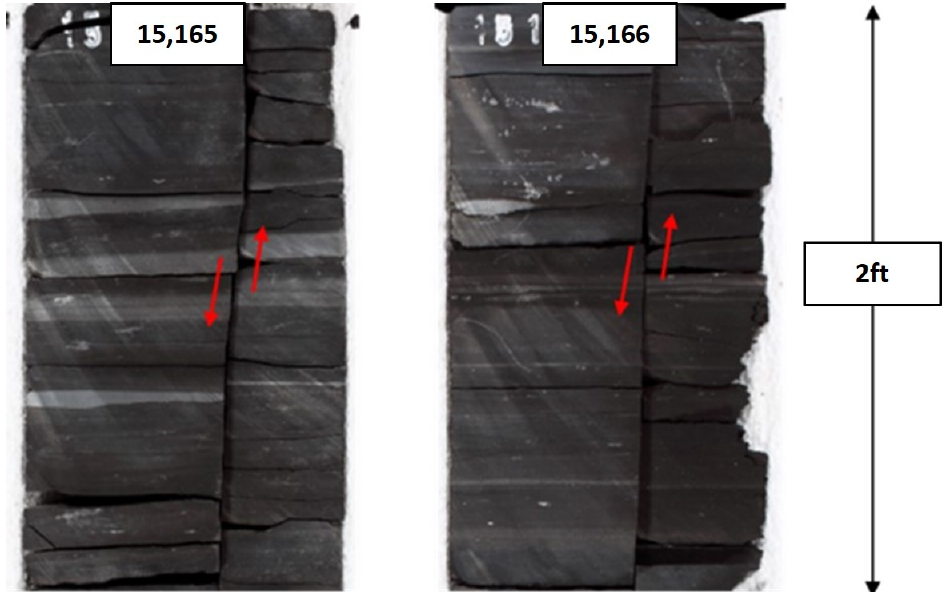
Figure 7. Example of a possible dip-slip (normal) fault in the Tuscaloosa Marine Shale, where the left compartment is moving downward relative to the compartment above the fracture. The direction of the movement of the fault is indicated using red arrows.